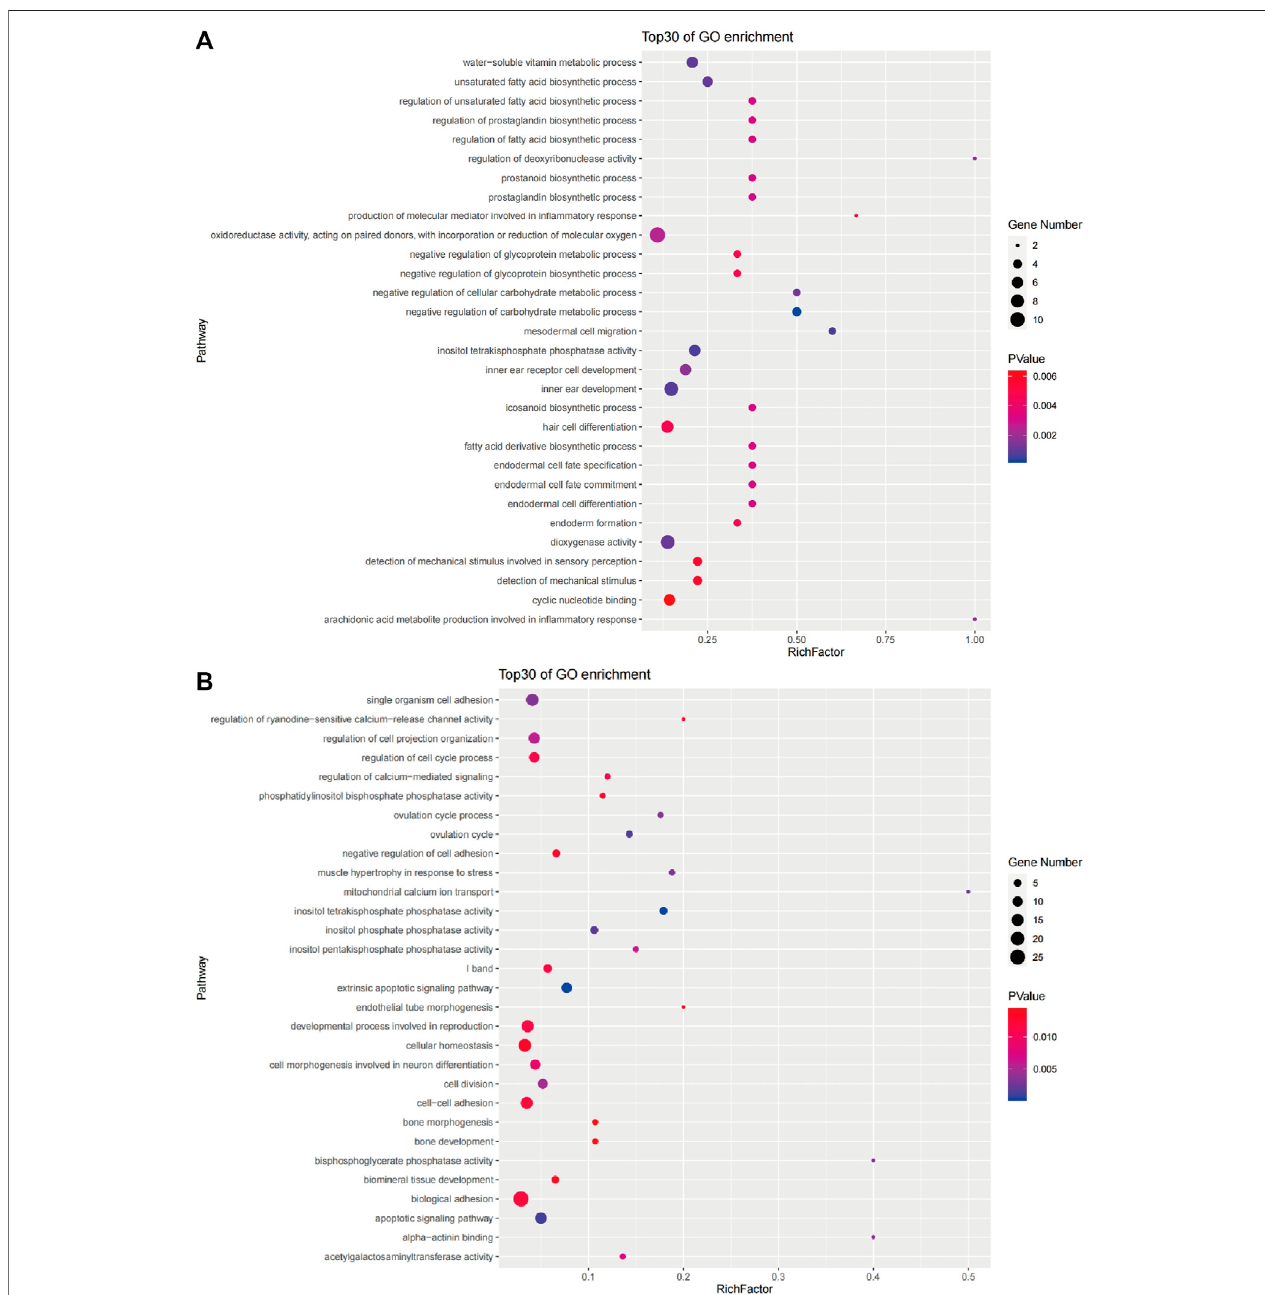
FIGURE 6 | The top 30 GO terms enriched by candidate genes of the brain (A) and liver (B) .